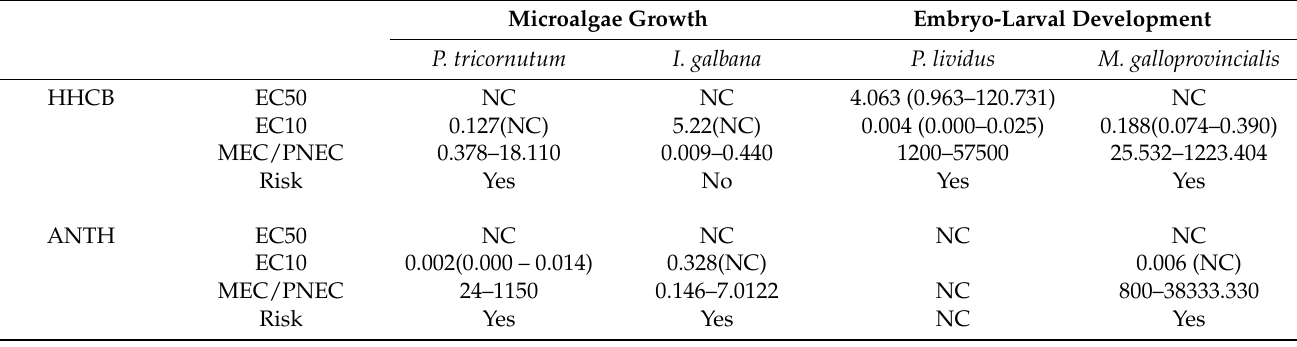
Table 2. Median lethal concentration (EC50) and EC10 ( µ g/L) and their respective confidence interval (CI), and estimated risk quotients of Galaxolide (HHCB) and Tonalide (AHTN) as the MEC (maximum value per location)—PNEC